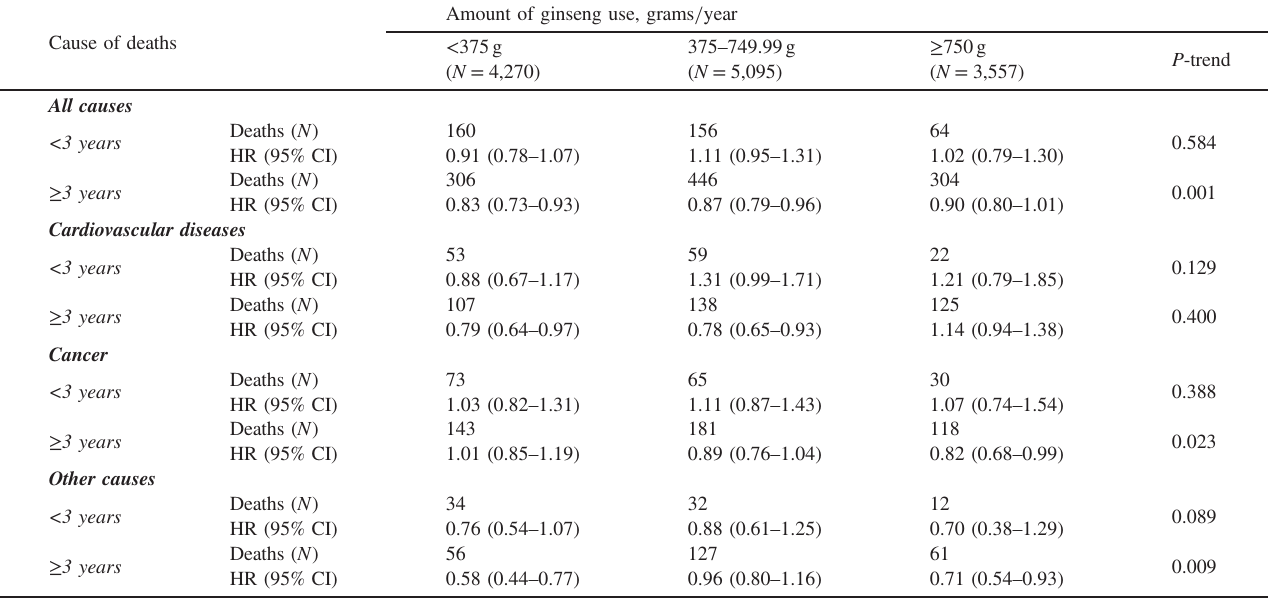
Table 5. The joint associations a of the amount and duration of consuming either American or White ginseng with mortality among individuals who consumed ginseng for perceived general bene fi t for enhancement of health, Shanghai Women ’ s Health Study Cause of